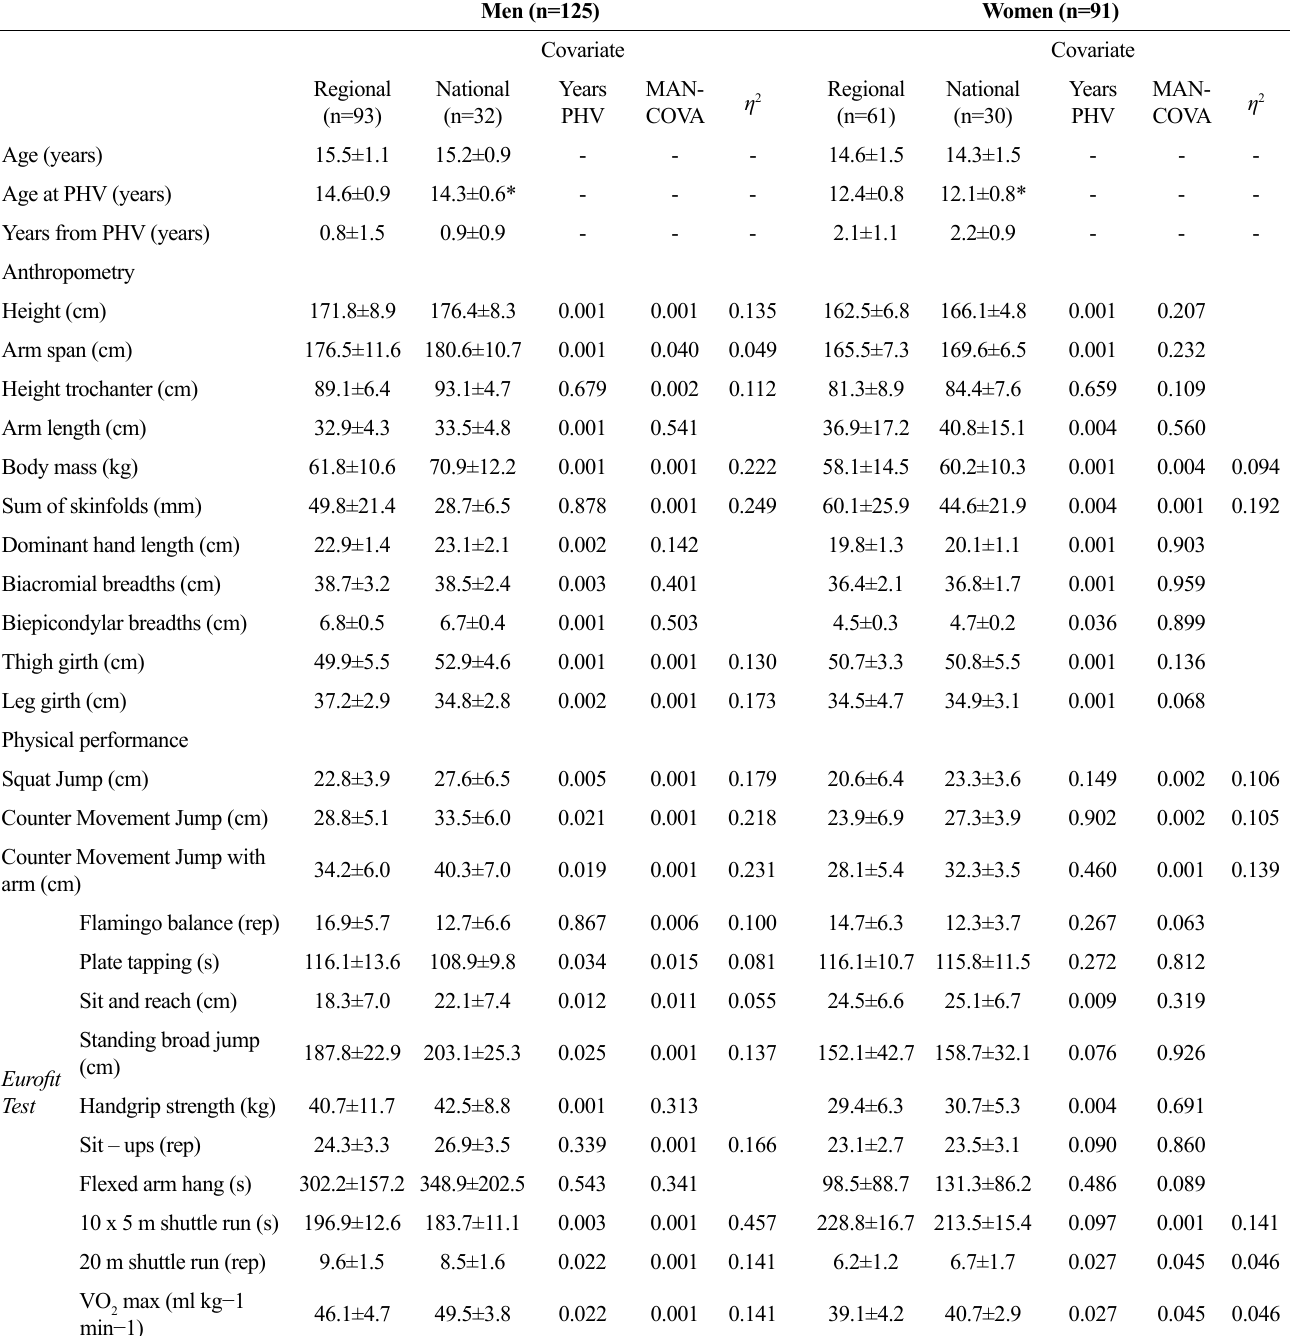
Table 1. Selection level characteristics (national vs. regional) of male and female handball